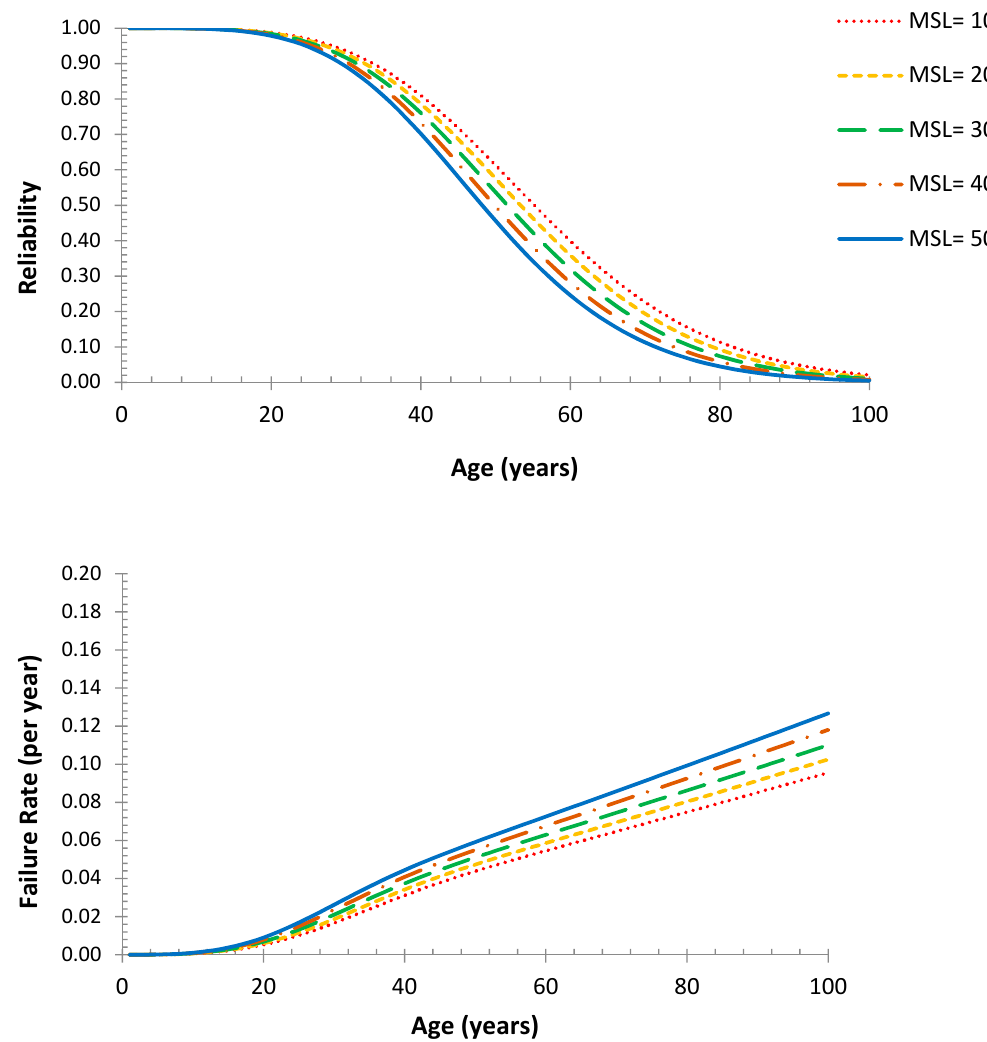
Figure 3. Superstructure reliability and hazard rate versus age at different maximum span lengths for ADT of 5000 (All superstructure types).